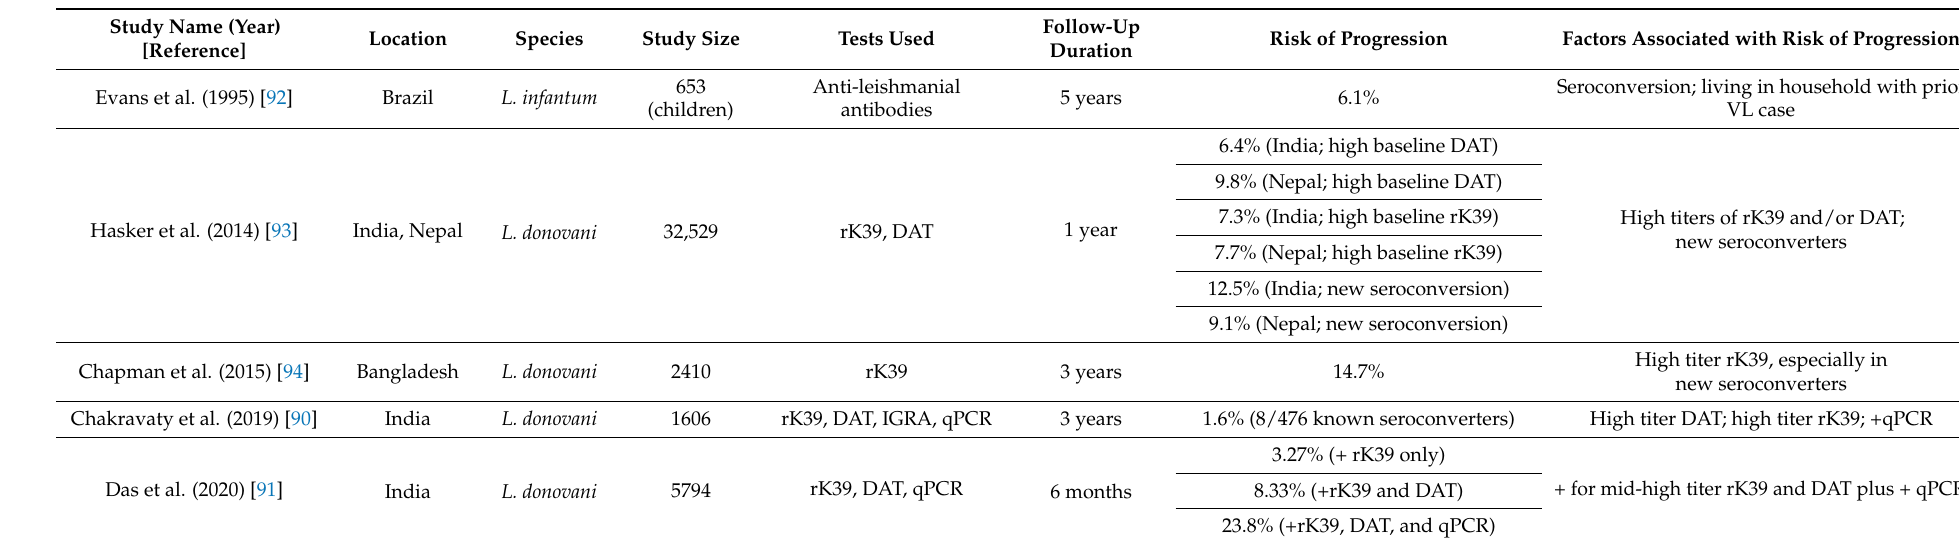
Table 3. AVL and Biomarkers for Progression to Symptomatic